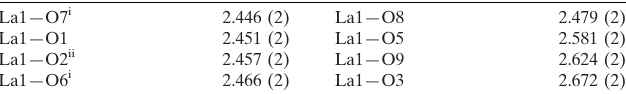
Selected bond lengths (A˚ ).